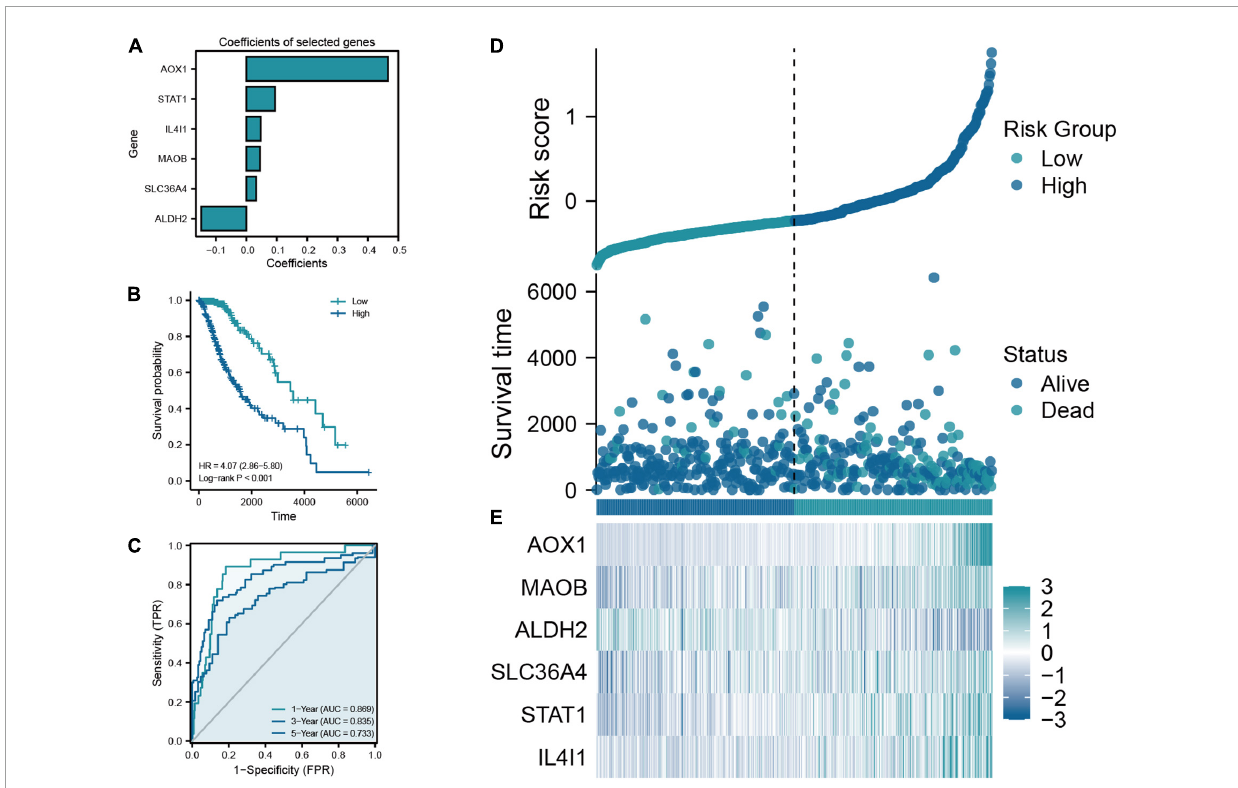
FIGURE3 (A) Coefficients of the six selected genes and the risk score formula. (B) The Kaplan-Meier plot comparing the low- and high-risk groups in overall survival (OS). (C) The ROC curve for low- and high-risk groups in the train cohort. (D) Scatter diagram of risk score and survival status in the train cohort. (E) The expression features of six key TRGs between the low- and high-risk groups in the training